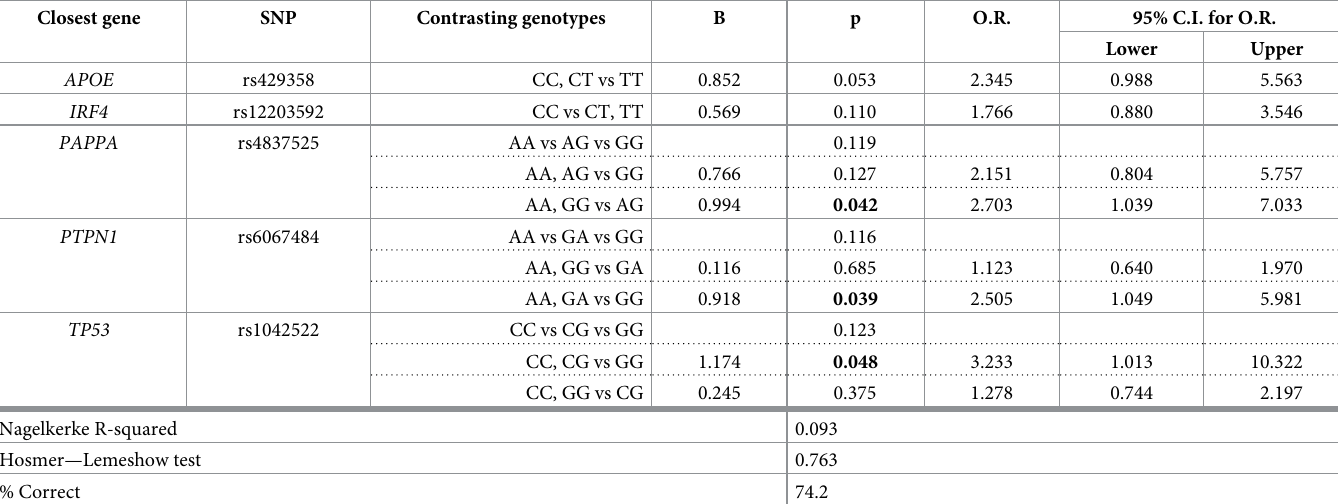
This table shows all the SNPs that together make up the best model for predicting survival to age 95+, the genotypes that were contrasted within the model, beta values, odd ratios and 95% confidence intervals. The p-values of SNPs that passed the significance threshold of p � 0.05 are highlighted in bold. Nagelkerke R-squared value, indicating the amount of variance explained by the model, is shown at the bottom of the table along with the results of Hosmer—Lemeshow test and the percentage of correctly classified